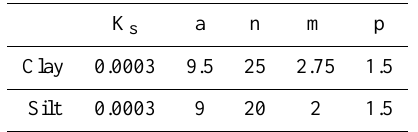
Table 3. Influence of the soil type; retention curve parameters for clay and silt.